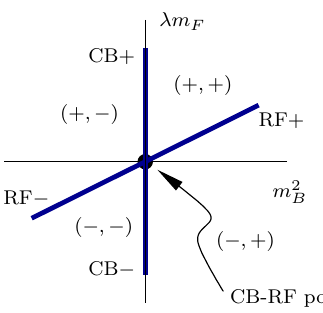
Figure 13. The features of the phase diagram of the N = 2 theory in the neighbourhood of the CB-RF conformal point depicted as a thick dot at the origin. The blue lines correspond to the CB (cid:6) , RF (cid:6) theories that emanate / terminate at the origin. The various topological phases are also